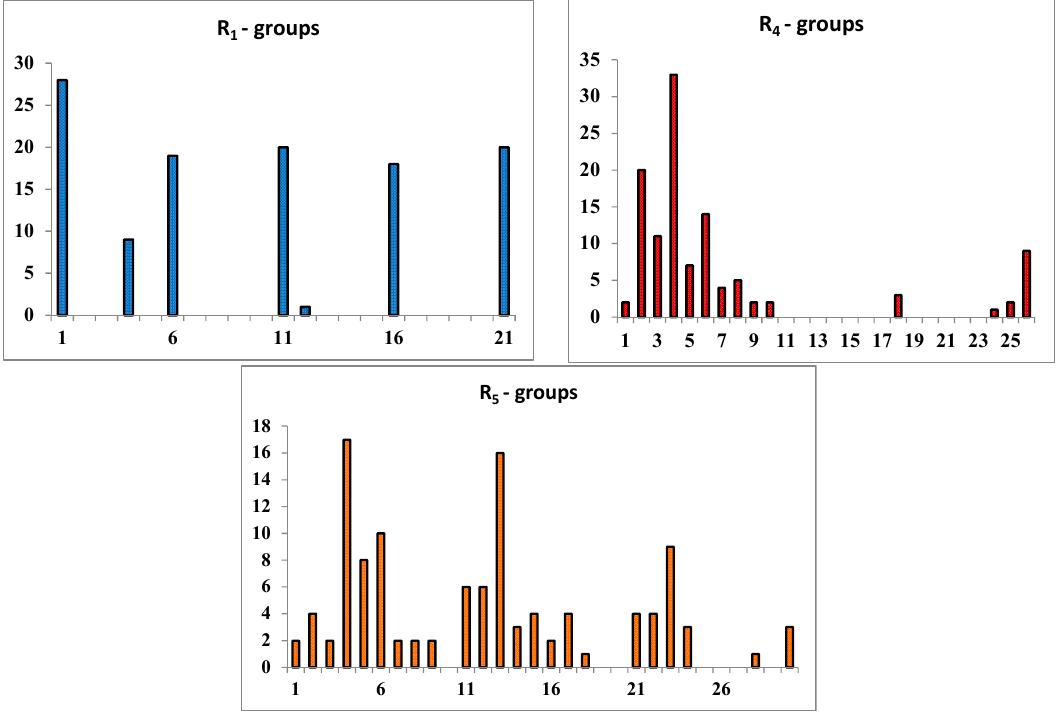
Figure 8. Histograms of frequency of occurrence of individual R 1 , R 4 , R 5 -groups in the 115 best-selected analogues mapping to the four features of the PH4 pharmacophore hypothesis Hypo1 (for fragments’ structures see Table 5); For R 2 and R 3 the occurrences are indicated in parenthesis: R 2 = –F (14), –Cl (97), –C ≡ CH (3), –NH 2 (1) and R 3 = –F (46), –H (69).